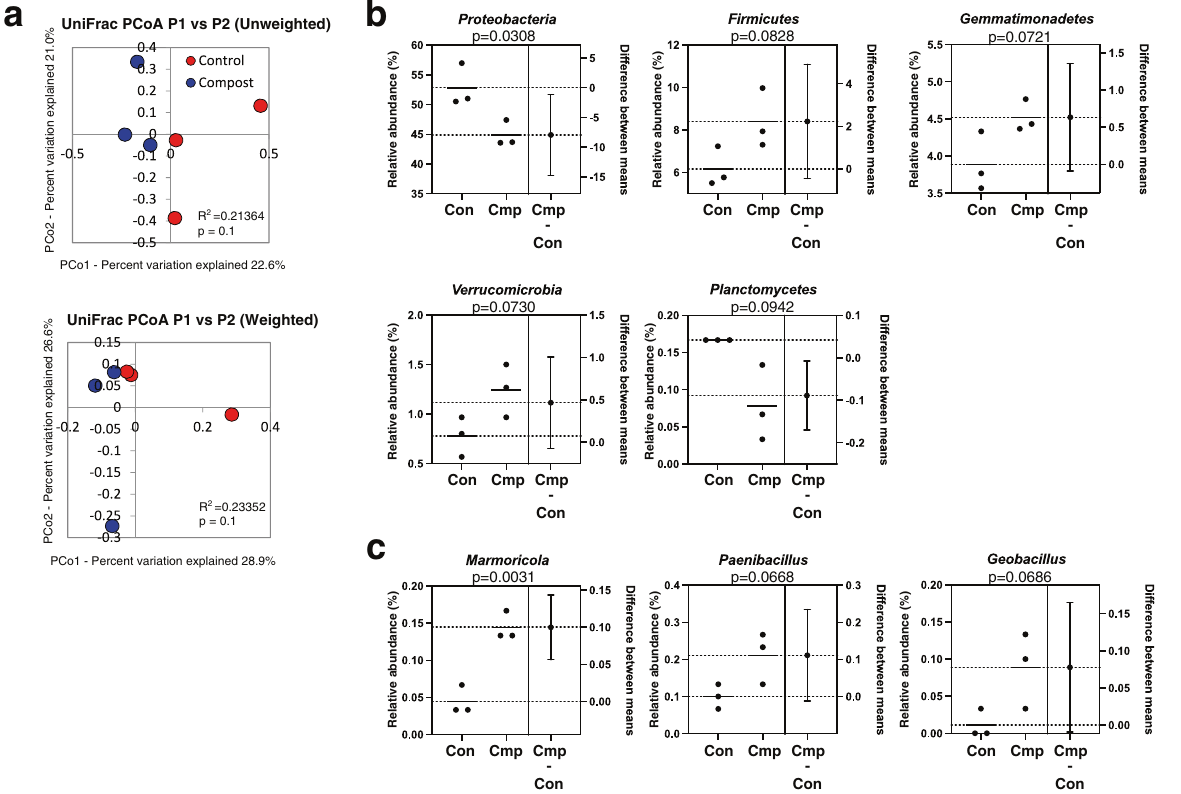
Fig. 4 Soil bacterial populations. a UniFrac graph (unweighted and weighted) showing β -diversity in the control and test groups. The estimation plot of the bacterial population in the soil of the control and test groups. Relative abundances of the ( b ) phyla and ( c ) genera ( p < 0.1; >0.1% as the maximum bacterial